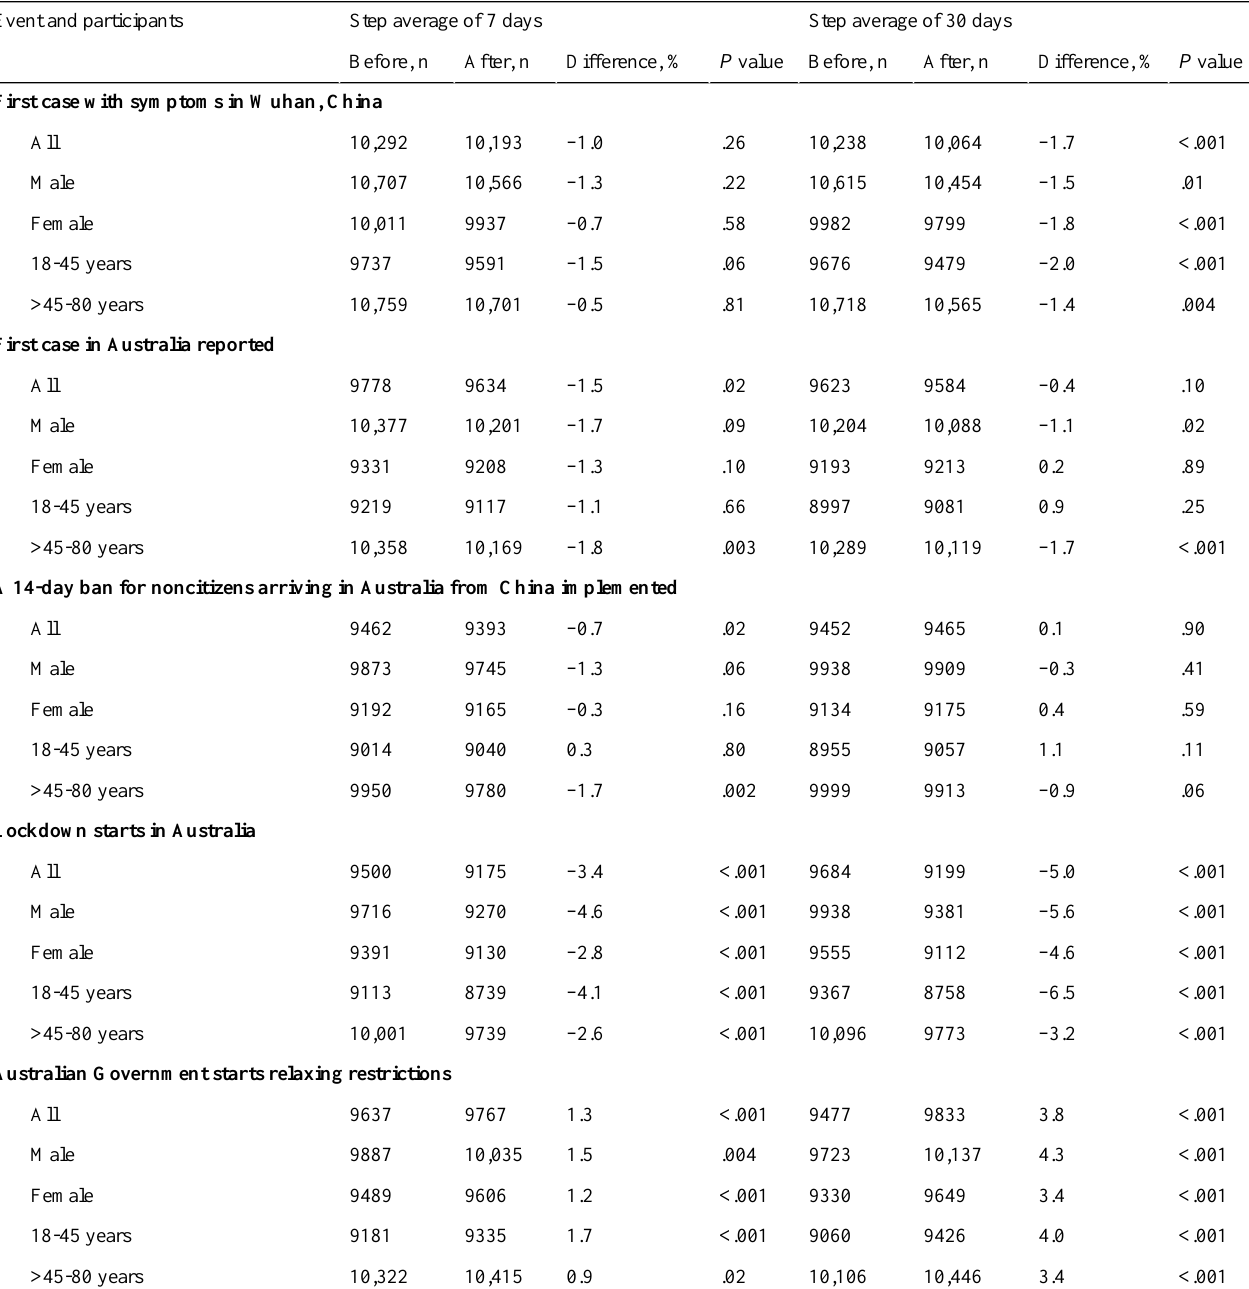
Table 2. Average daily steps of 7 and 30 days before and after each event.